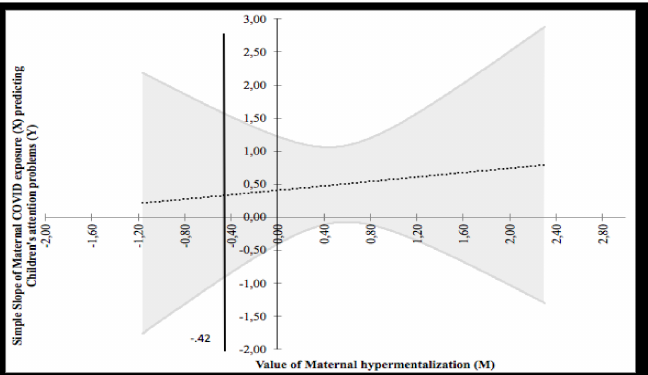
Figure 5. Probing interaction with the Johnson–Neyman technique for the COVID-19 exposure predictor and the maternal hypermentalization moderator on children’s attention problems.